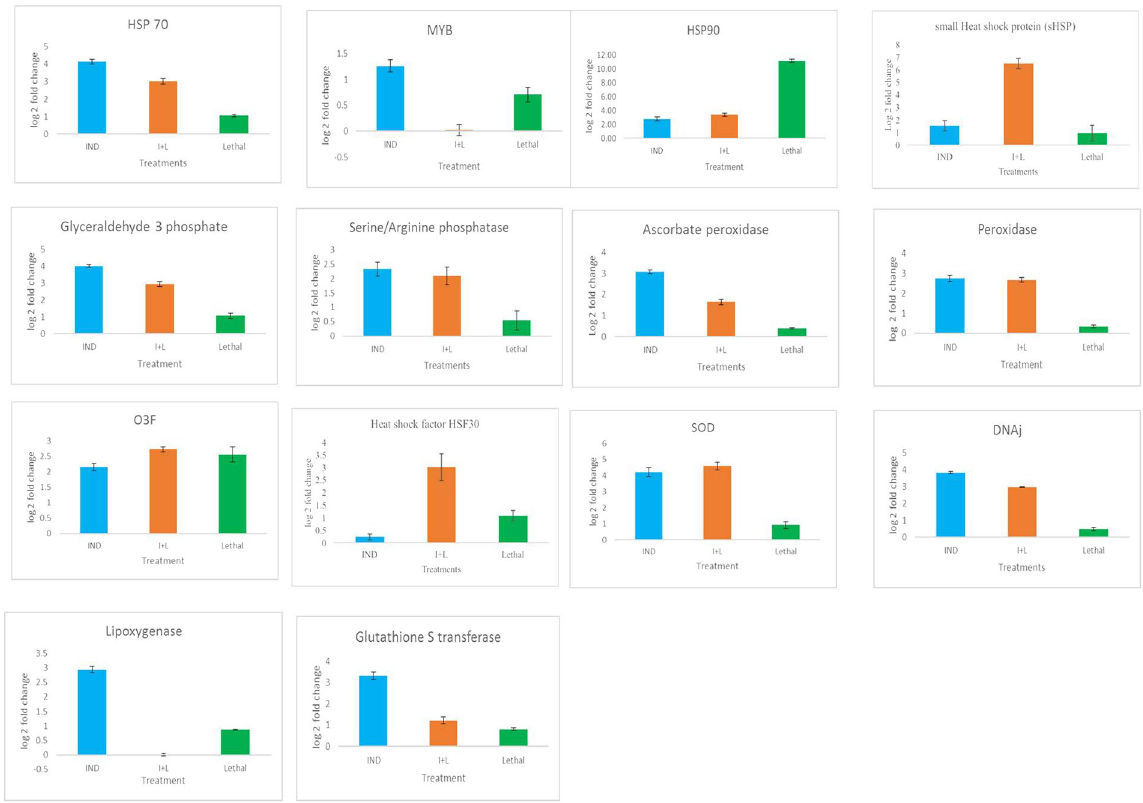
Figure 6. Expression levels of 12 genes after IND, I + L and Lethal stress were examined by qRT-PCR. The mRNA fold difference was relative to that of untreated control sample used as calibrator. Data are means ± SE of n = 3 independent